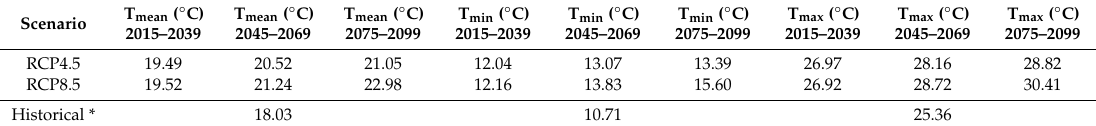
Table 5. Projected changes of annual T mean , T min , and T max under the RCP4.5 and RCP8.5